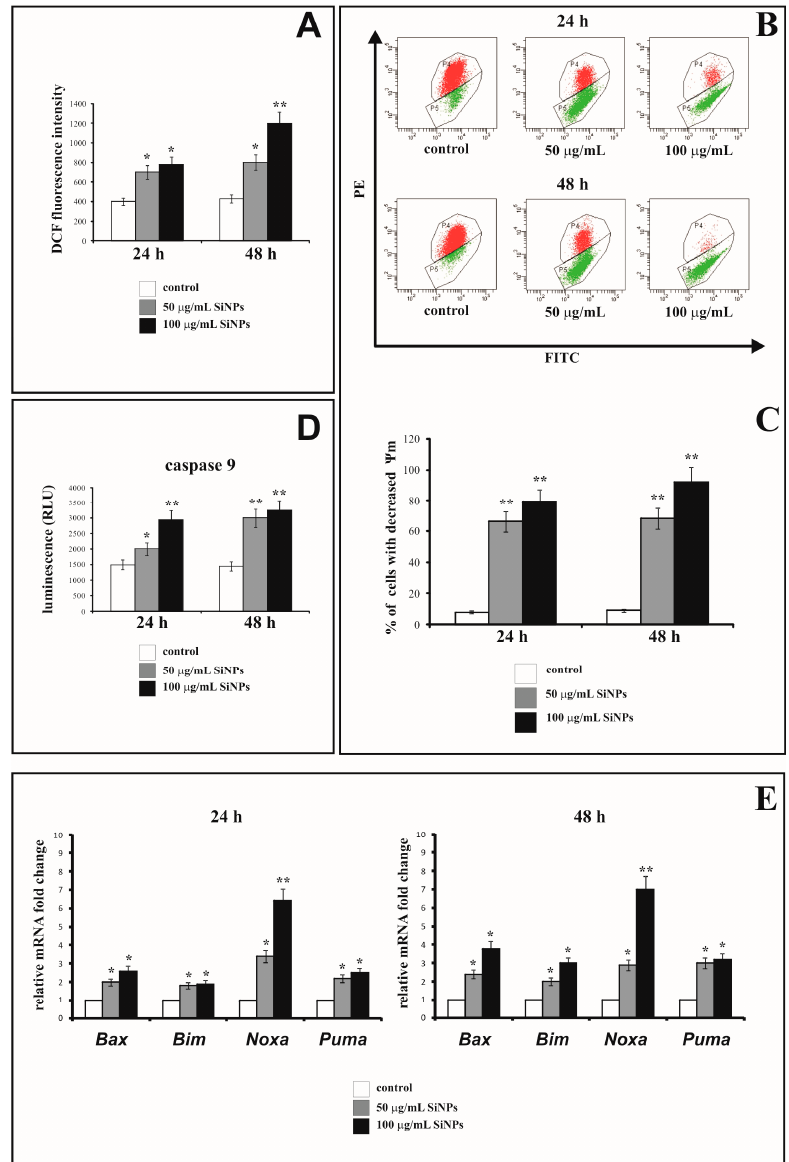
Figure 4. Oxidative stress and biochemical changes induced by 5–15nm SiNPs in LBC3 cells. The cells were treated with 50 and 100 µ g/mL of 5–15 nm SiNPs for 24 and 48 h. Intracellular reactive oxygen species (ROS) production in LBC3 cells is presented on panel A . Panel B shows the flow cytometry analysis of ∆Ψ m in LBC3 cells. The top panel B shows representative dot plots of LBC3 cells analyzed by JC-1 staining. X-axis and Y-axis are green and red fluorescence, respectively. The gate P4—populations of cells with normal ∆Ψ m and gate P5—population of cells with decreased ∆Ψ m. The lower panel C shows the percentage of LBC3 cells with decreased ∆Ψ m. Panel D shows activity of caspase-9 in LBC3 cells. Relative quantification of proapoptotic genes expression in LBC3 cells is presented in panel E . Results are shown as a relative fold change in mRNA expression in comparison to untreated controls, where expression level was set as 1. Significant alterations are expressed relative to controls and marked with asterisks. Statistical significance was considered if * p < 0.05 or ** p < 0.001.